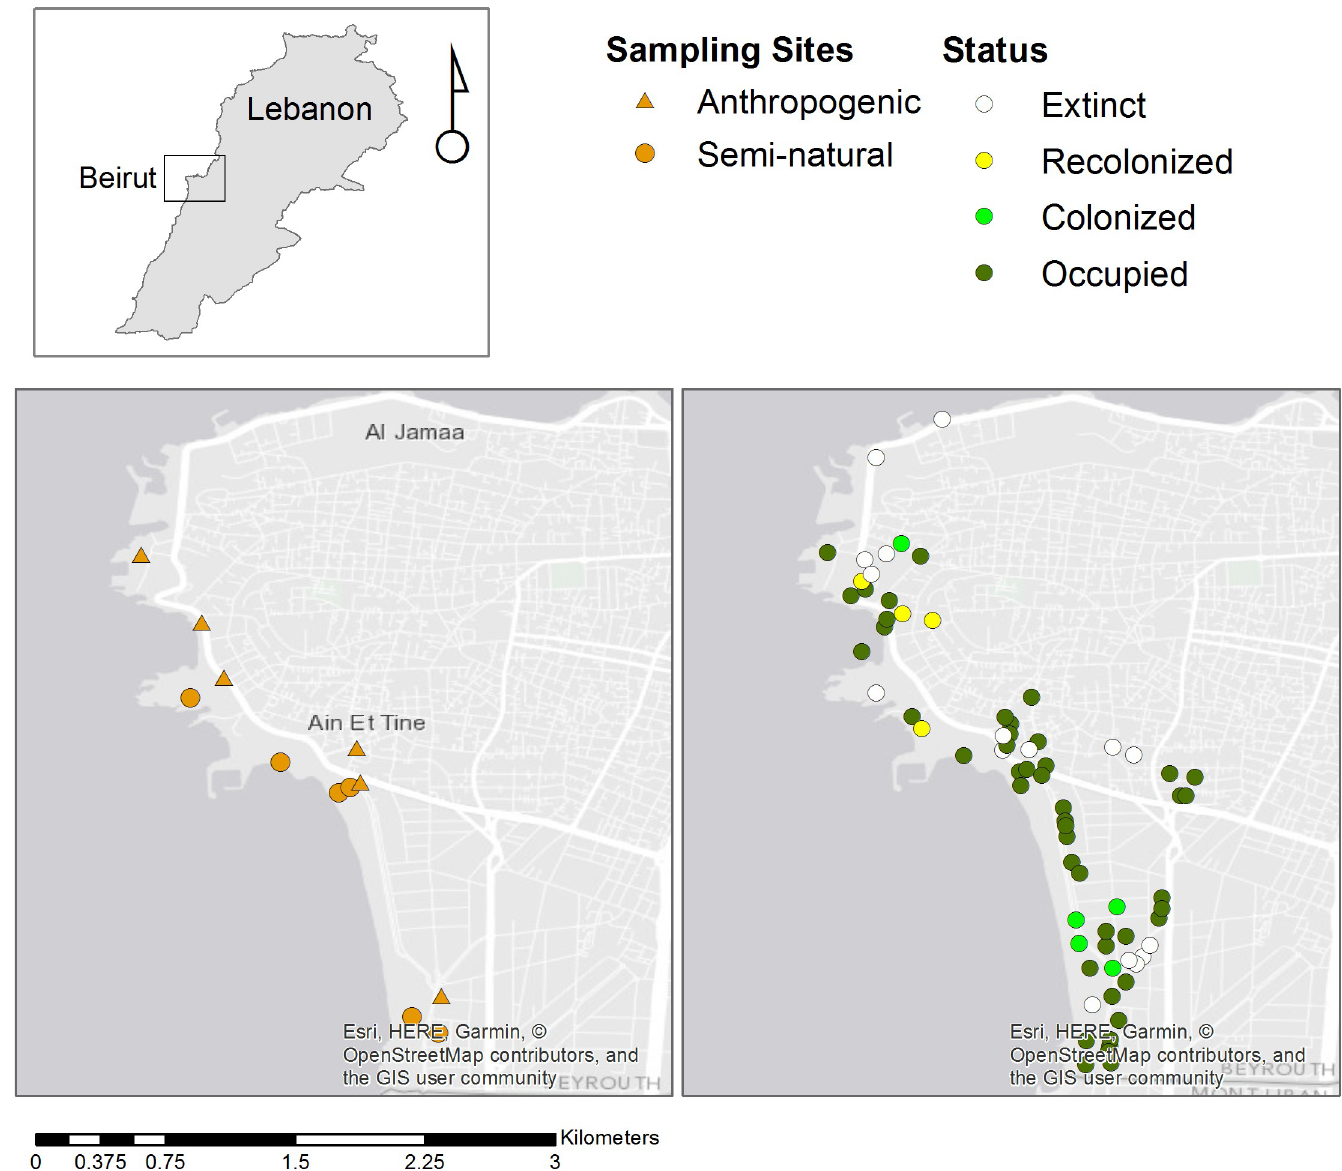
Fig 2. The distribution of M . crassifolia in Beirut and selected sites for the